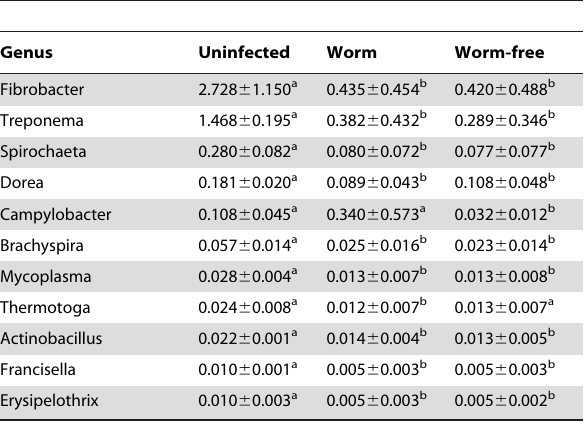
Table 2. Genera significantly impacted by helminth infection in the porcine colon